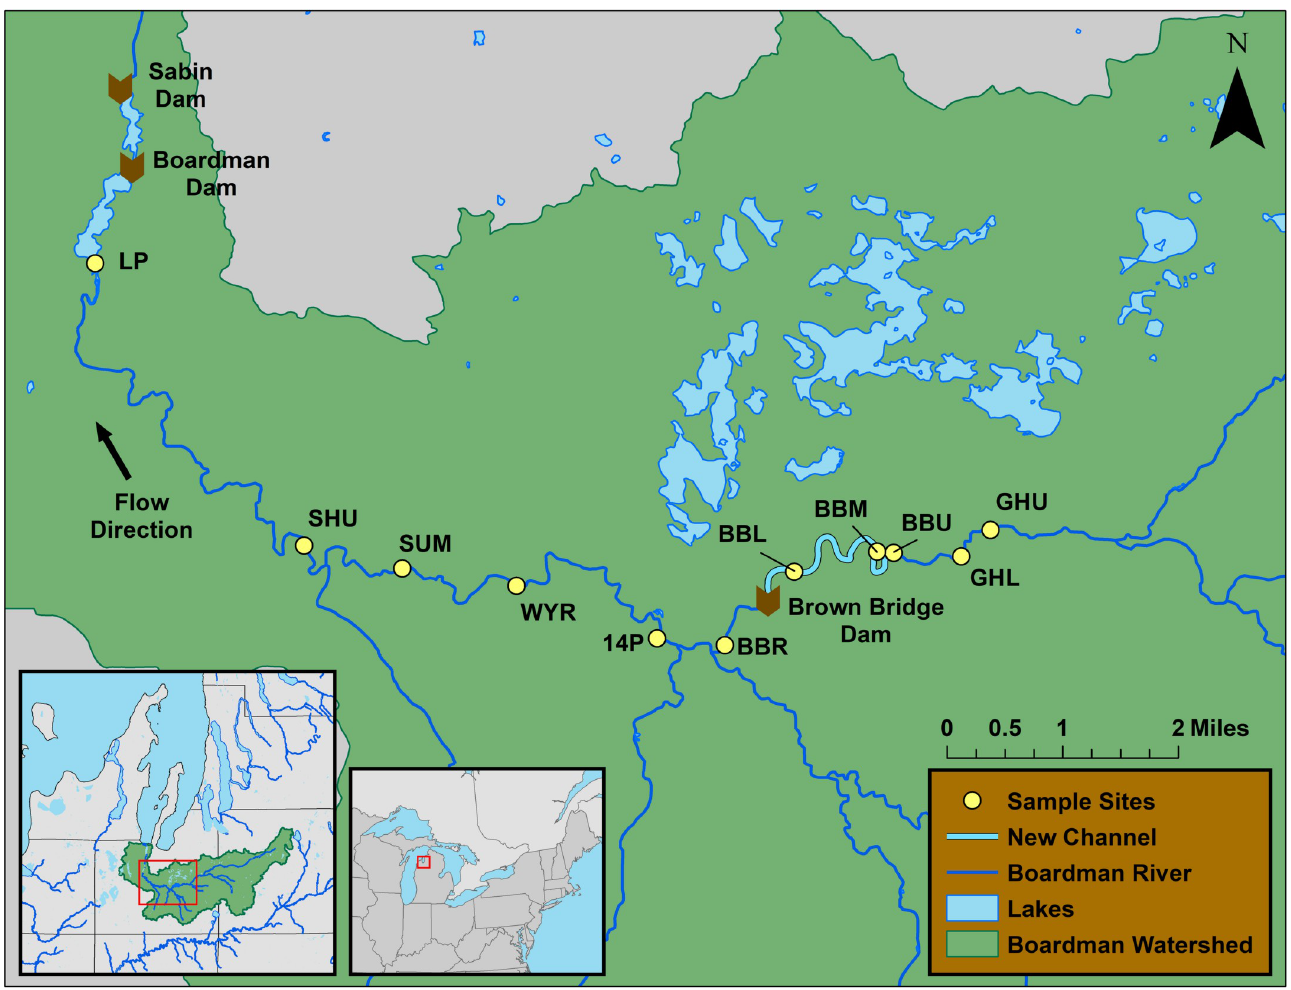
Fig 1. Location of study sites and Boardman River dams for riffle macroinvertebrate survey, 2011–2016, Boardman River, Michigan, USA. See Table 1 for full names and locations of sites. The Brown Bridge, Boardman, and Sabin dams were removed in 2013, 2017, and 2018, respectively. Reservoirs are pictured for later-removed dams that were removed after the study period. Maps generated by J. Betts in ArcMap, using publicly available shapefiles from the Michigan Geographical Framework (https://www.michigan.gov/som/0,4669,7-192-78943_78944---,00.html). 1 June 2013 [28].